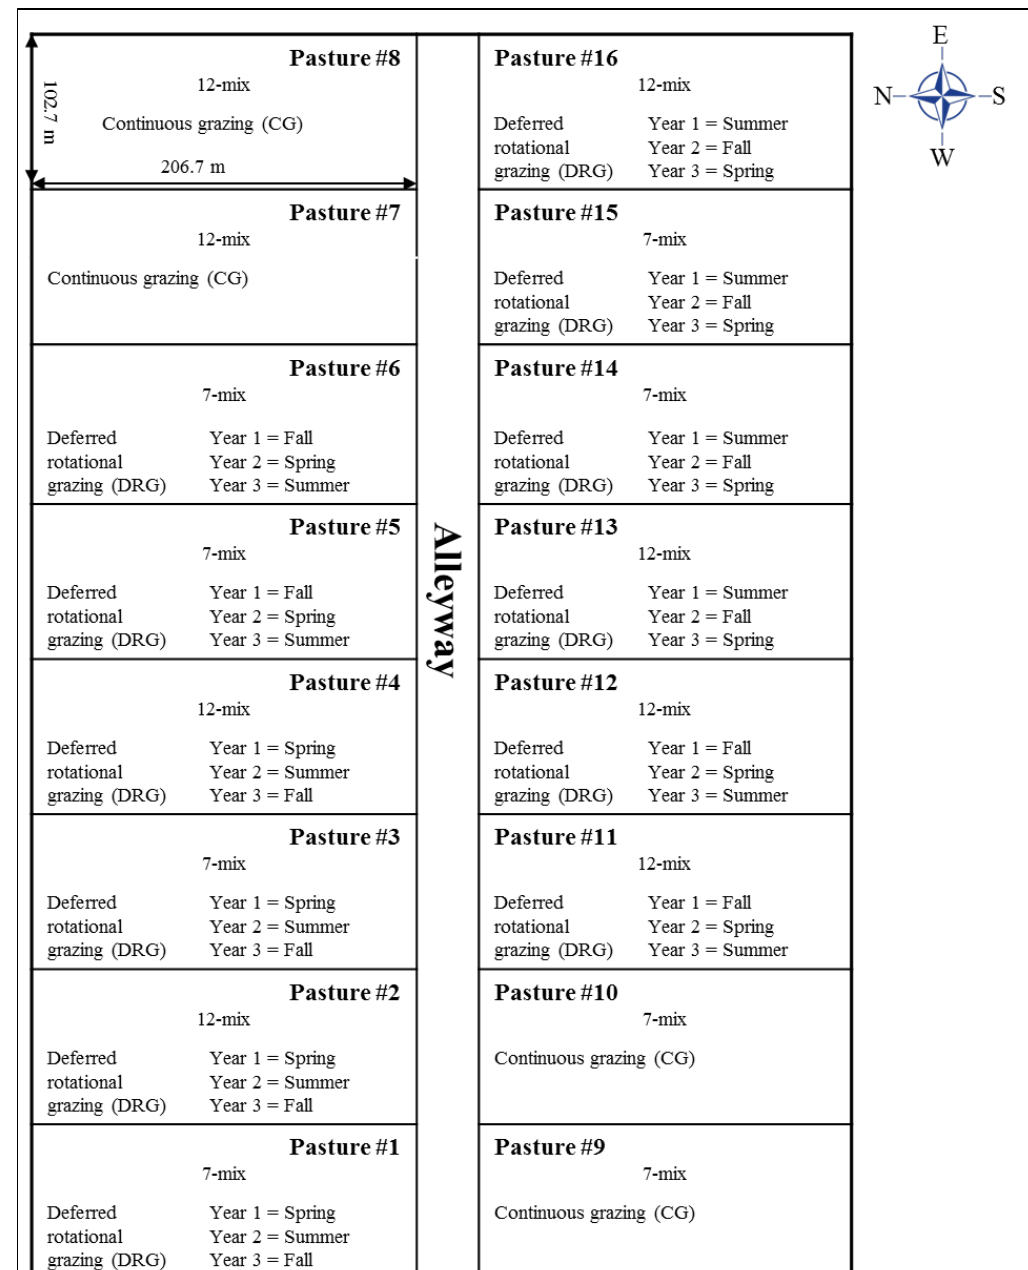
Figure A1. Pasture plots design of different grazing systems (continuous versus deferred rotational) on 7-mix or 12-mix mixed native grassland. The area of each pasture is 2.1 ha.